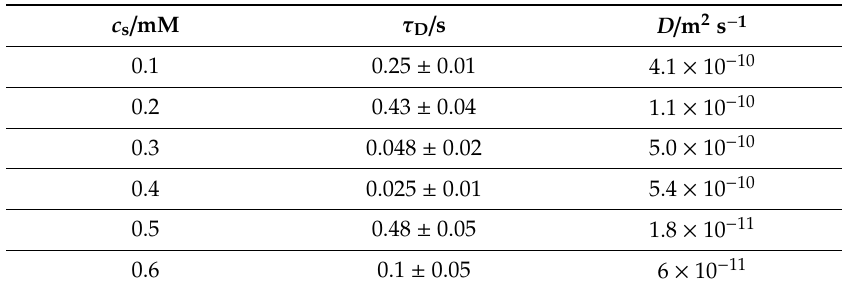
Table 1. Characteristic times obtained from fittings with Equation (3), and the diffusion coefficients, D, calculated with Equation (4). The surfactant concentrations are all below the cmc.